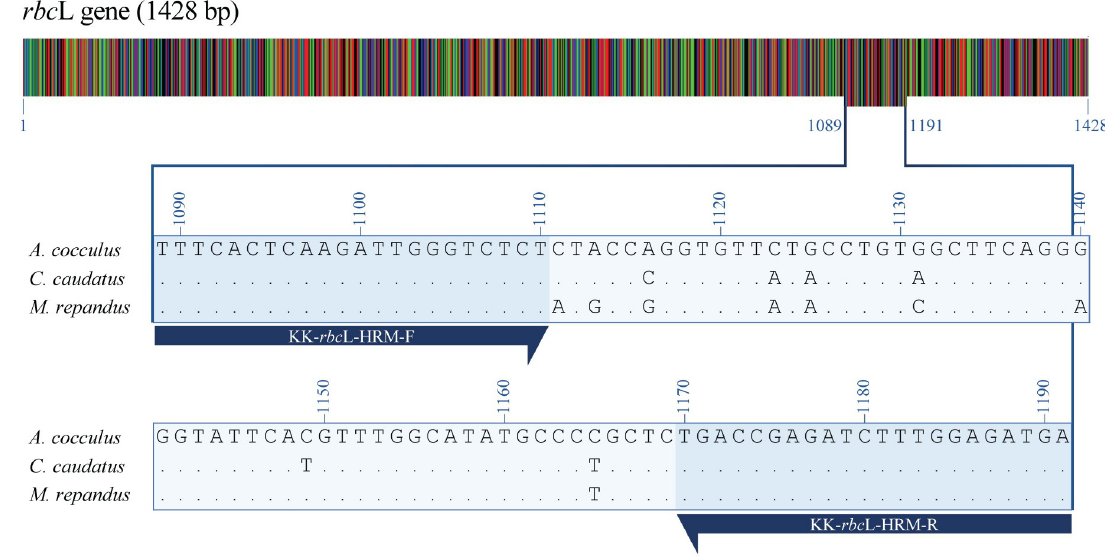
Fig 4. Illustration of the rbc L target region for Bar-HRM analysis on the alignment of A . cocculus , C . caudatus and M . repandus with nucleotide polymorphic sites. Blue arrows present forward primers (KK-rbcL-HRM-F) and reverse primers (KK-rbcL-HRM-R) with their directions. Consensus sequences are indicated with dots. The altered bases indicate sequence differences.